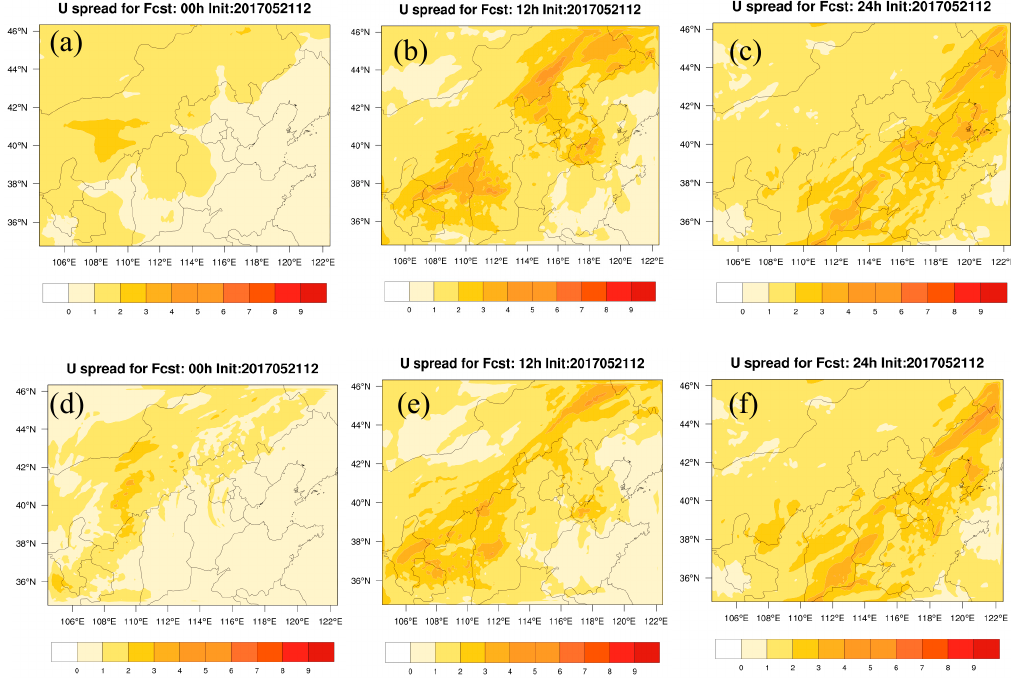
Figure 5. Horizontal spread of the zonal wind (unit: m · s − 1 ) at different forecast lead times for the Breeding and Down ensembles. ( a ) Down 00 h; ( b ) Down 12 h; ( c ) Down 24 h; ( d ) Breeding 00 h; ( e ) Breeding 12 h; and ( f ) Breeding 24 h.